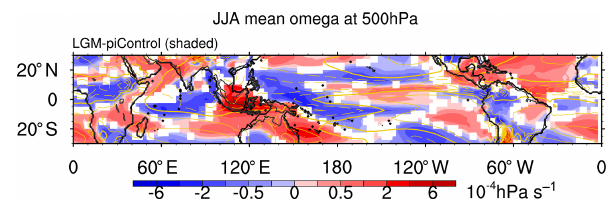
Figure 4. The difference of JJA mean vertical velocity at 500hPa between LGME and piControl (in shading) and the corresponding climatology derived from piControl (yellow contours). The thick black lines denote the coastal lines in LGME provided by CMIP5– PMIP3, and the thin black lines denote the coastal lines in piCon- trol. Only those areas where the signal-to-noise ratio exceeds 1 are plotted in the difference